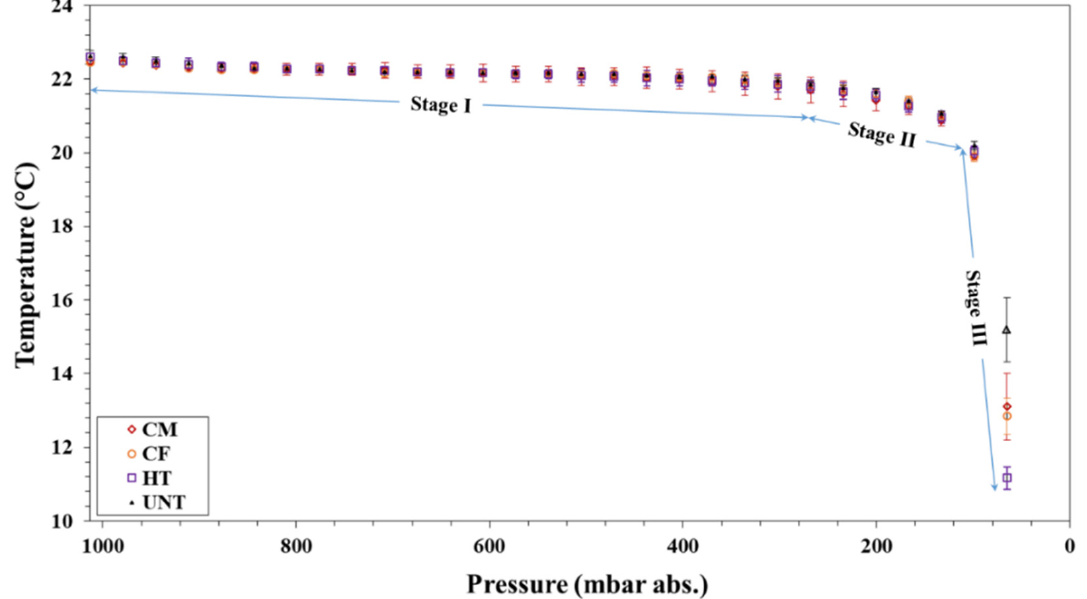
Figure 4. Measured temperature vs. vacuum trends of water in hydrophilic (untreated) and hydrophobic (CM, CF and HT) vials.